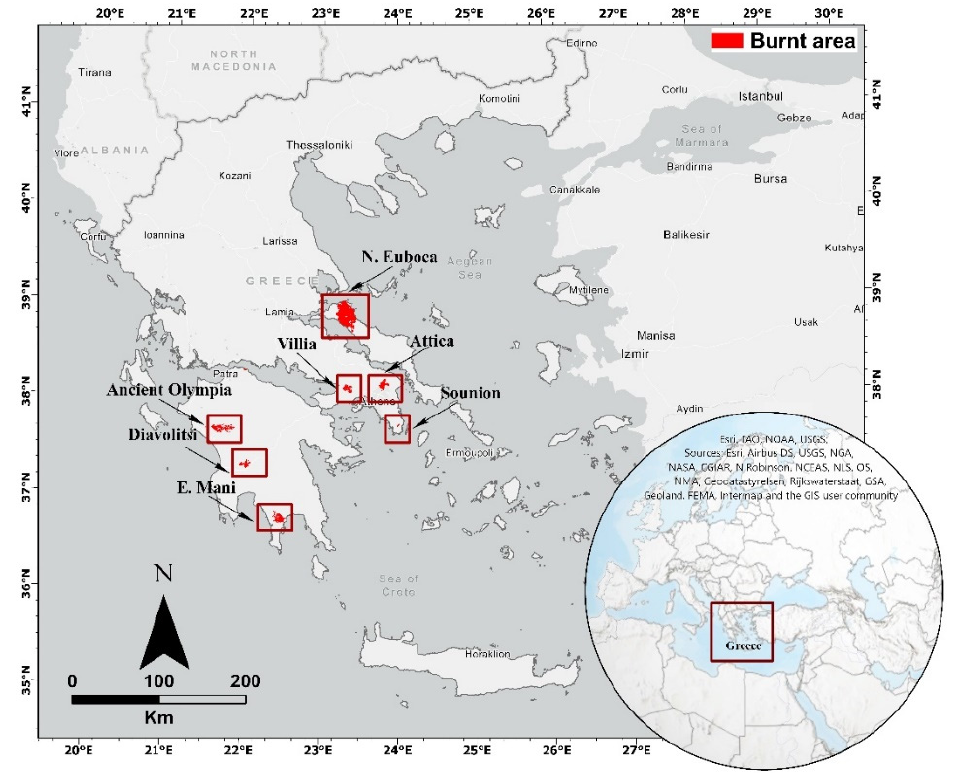
Figure 1. Location of the studied